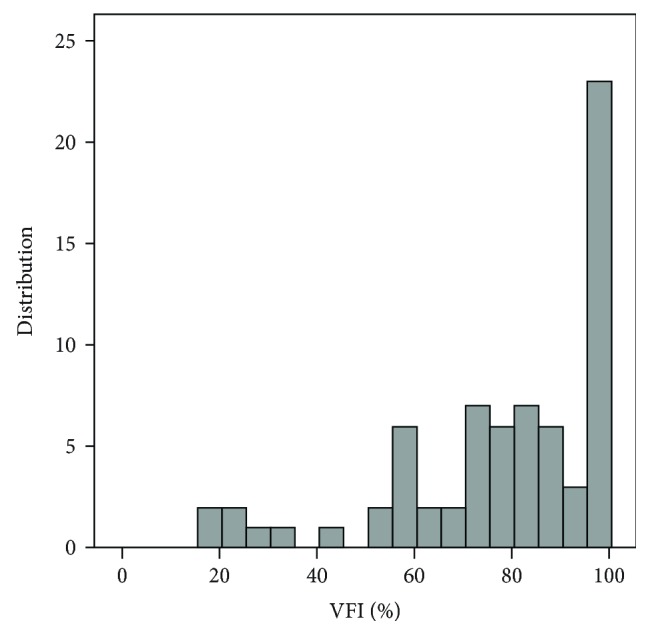
Distribution of disease severity, as measured by the VFI in the glaucoma group.